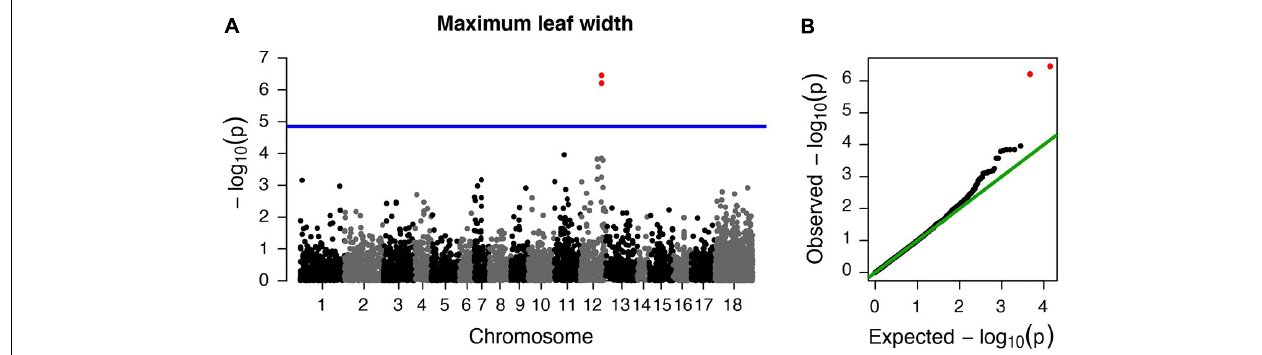
FIGURE 3 | Centaurea diffusa GWAS Manhattan and QQ plots for one trait with significant associations. Manhattan and QQ plots for maximum leaf width. (A) The horizontal blue line represents a p -value threshold of 0.05 after accounting for Bonferroni multiple test correction. (B) QQ plot showing the expected –log10 p -values plotted against the observed –log10 p -values. Red points denote the two markers that exceed our significance threshold.